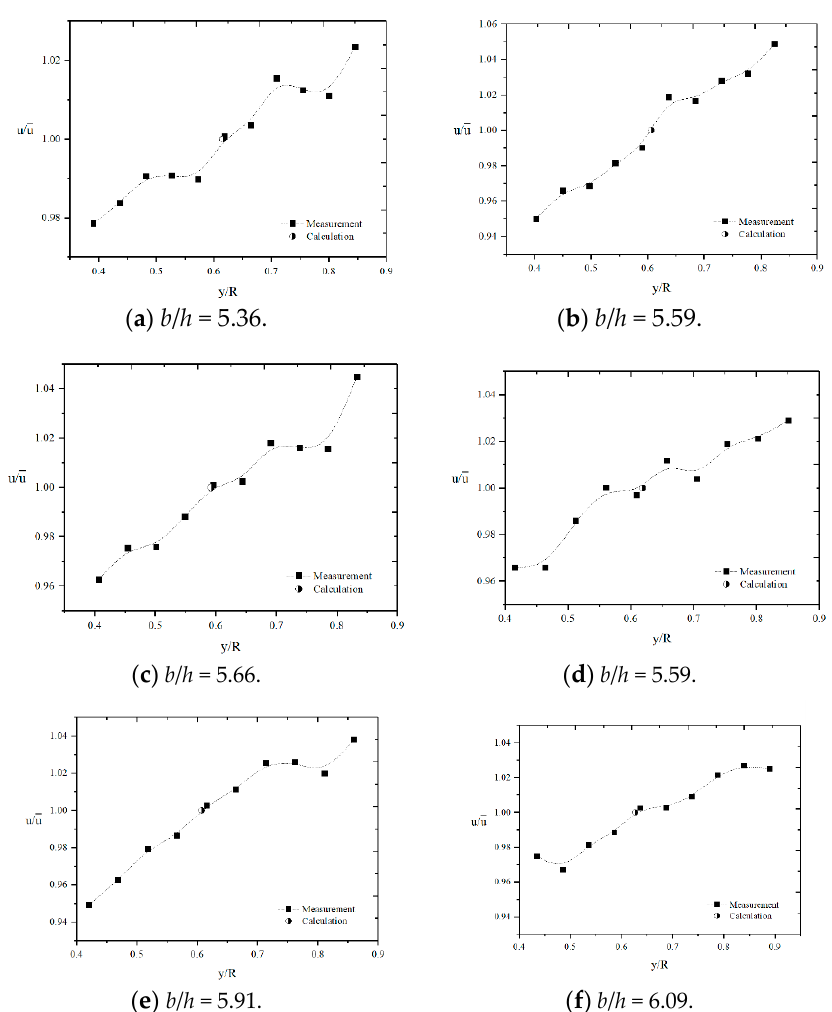
Figure 10. Velocity distribution and the location of depth average velocity in the center line under different experimental conditions (( a – f ) show results for different aspect ratios).